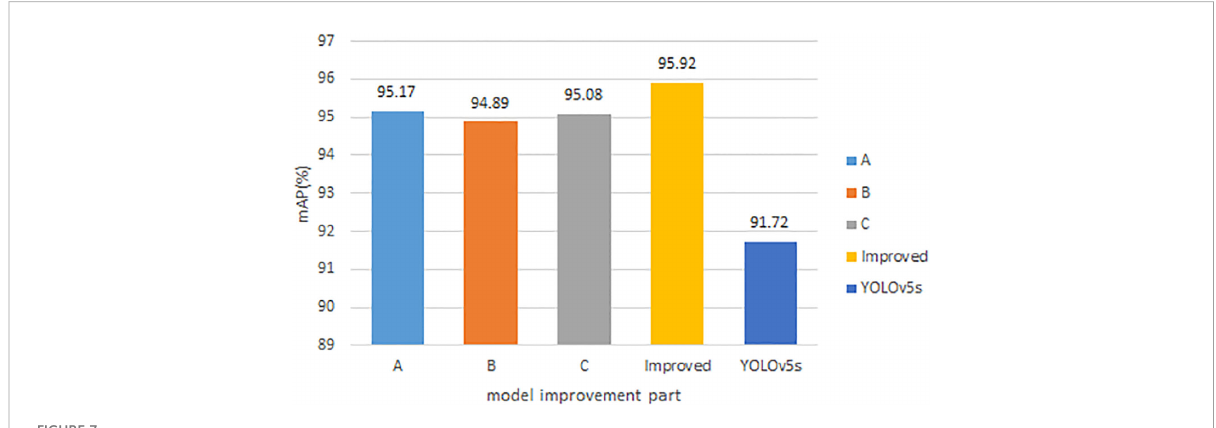
FIGURE 7 Comparison results of each improved part of the